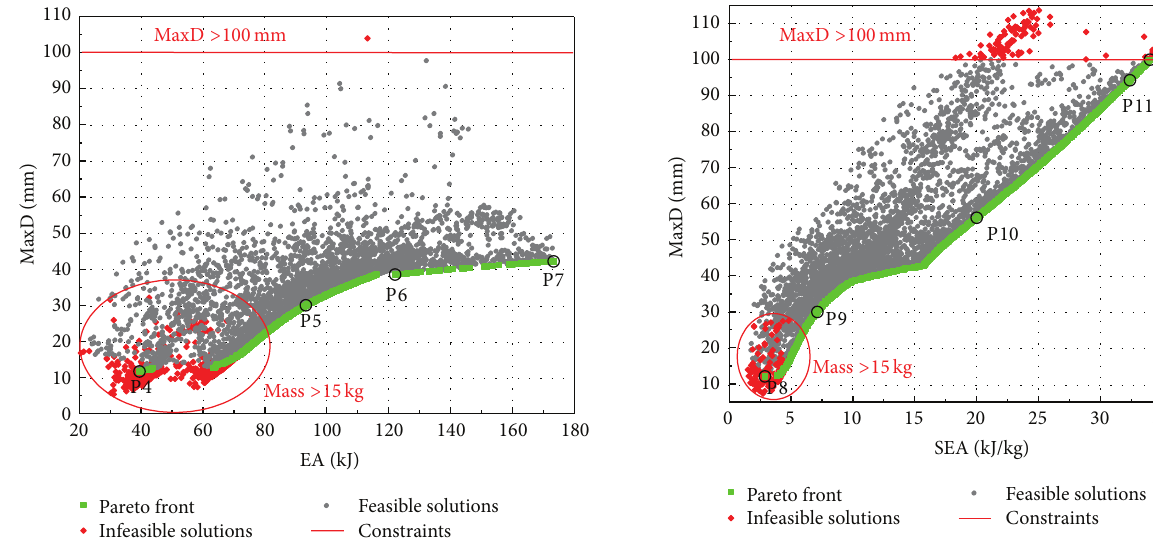
Figure 14: Optimization results of Case Study 2.